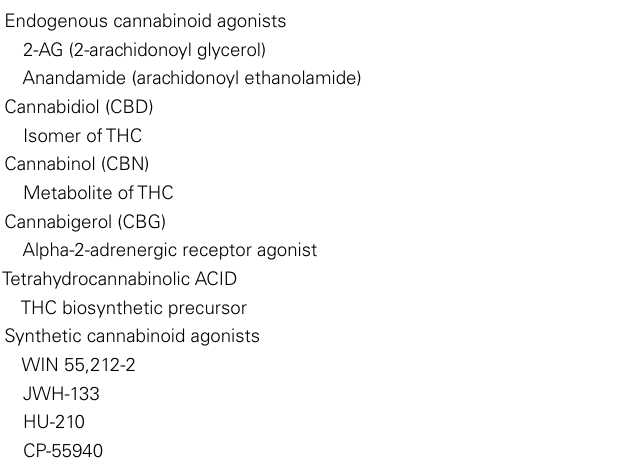
Table 2 |Types of